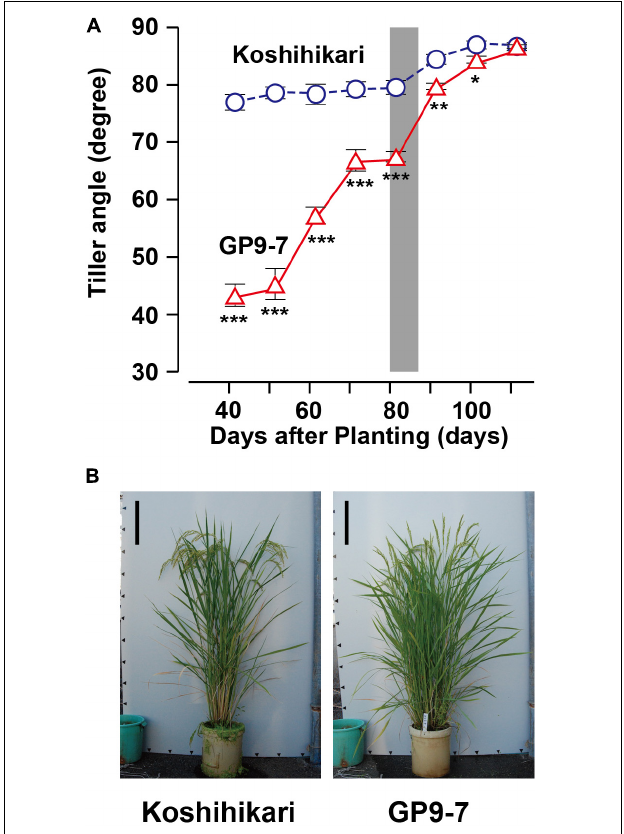
FIGURE 2 | Basic properties of GP9-7 toward the reproductive growth phase. (A) Developmental transitions of tiller angles from horizontal in Koshihikari (blue circles with broken lines) and GP9-7 (red triangles with solid lines) grown in a test field at Tsukuba, Japan in the summer of 2020 (planting date: May 21, 2020). The tiller angles of the same six plants were continuously measured and the mean values with SE were shown in the graph. The period for heading is indicated by a vertical gray bar. Symbols, ***, **, and * indicate statistically significant differences compared to Koshihikari at P < 0.001, P < 0.01, and P < 0.05, respectively, calculated by the Welch’s t -test. The photographs (B) display typical plant shapes of Koshihikari and GP9-7 during the ripening phase (25 days after heading). Scale bars: 20 cm.